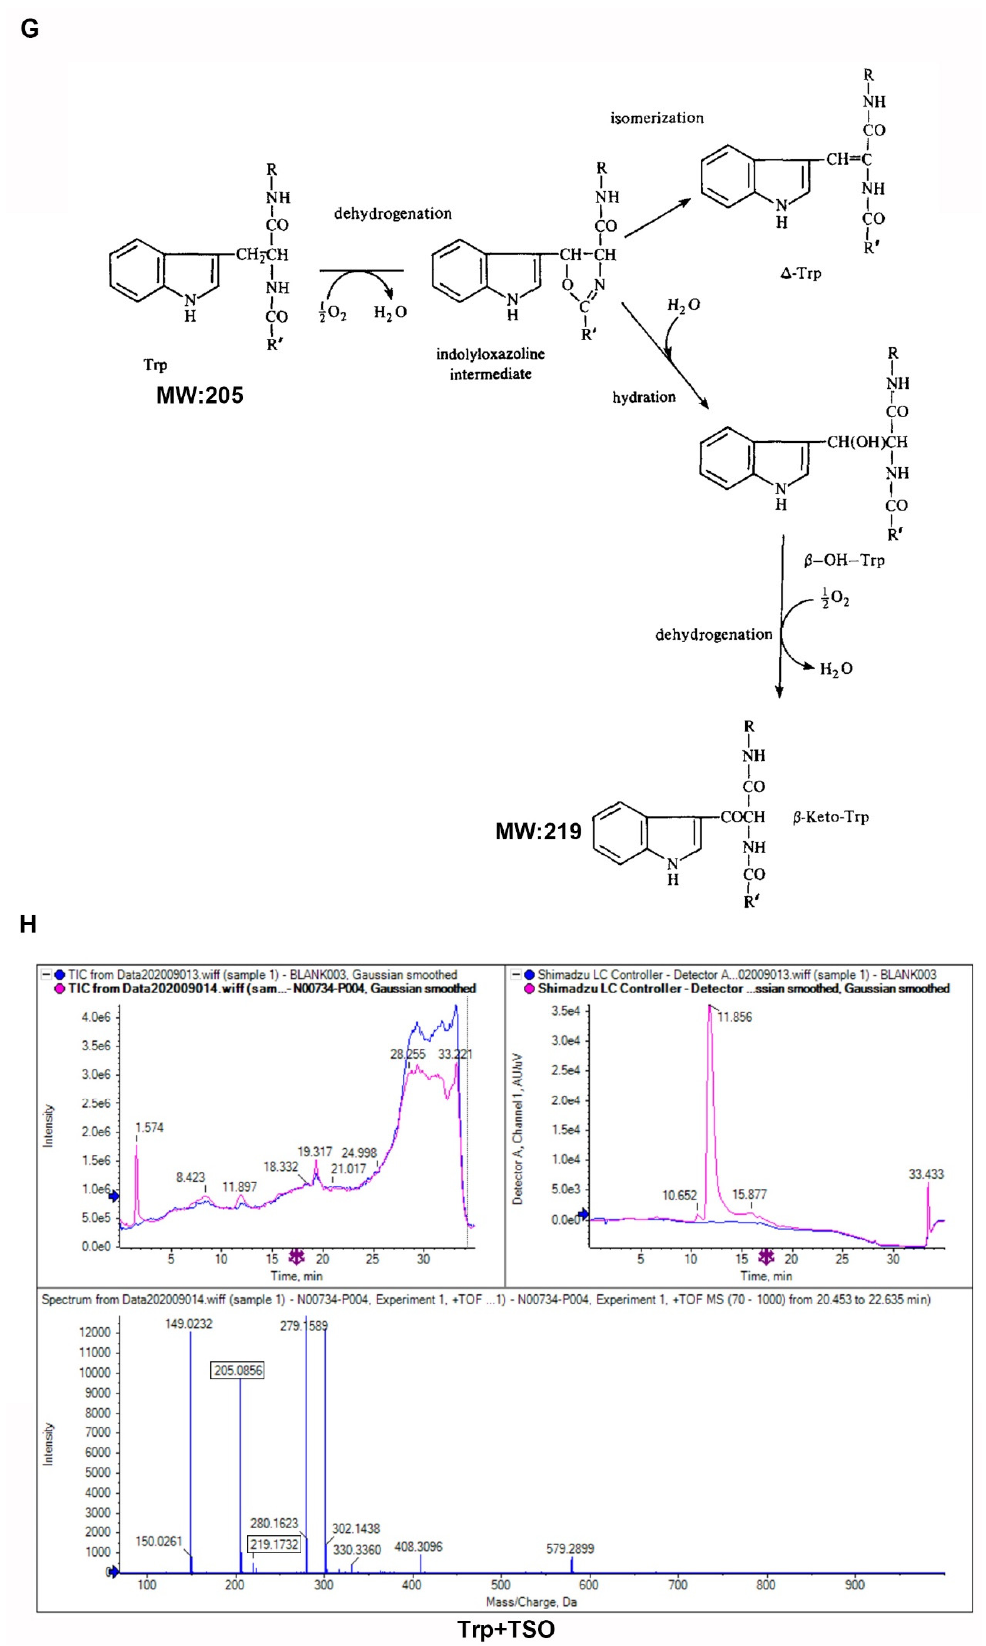
Figure 2. Tryptophan can be completely degraded by TSO. ( A – E ) The peak at 4.5 min was kynurenine, and the peak at 6.5 min was tryptophan. 604 was the number of siRNA of TDO2. ( F ) Compared with the normal control group, the